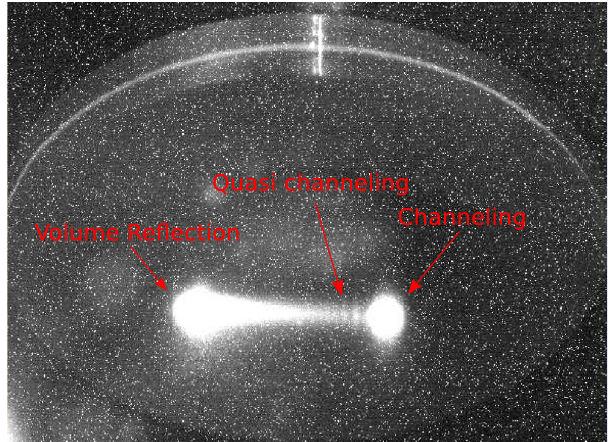
FIG. 2. Image of the YAG screen with the crystal in channeling